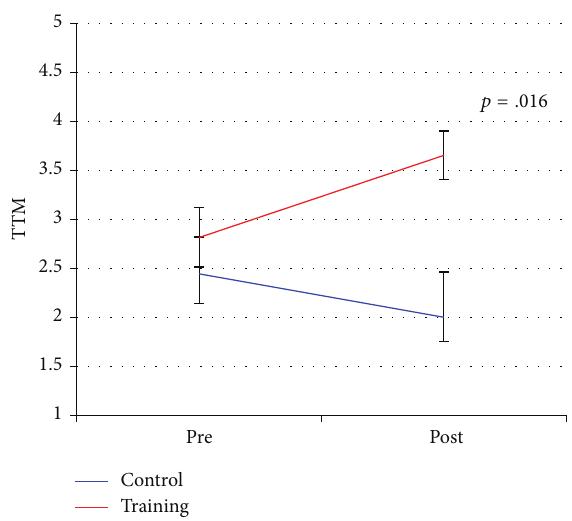
Figure 2: Effects of exercise training on stages of change for the training and control group. Note . Values as means; error bars indi- cate standard